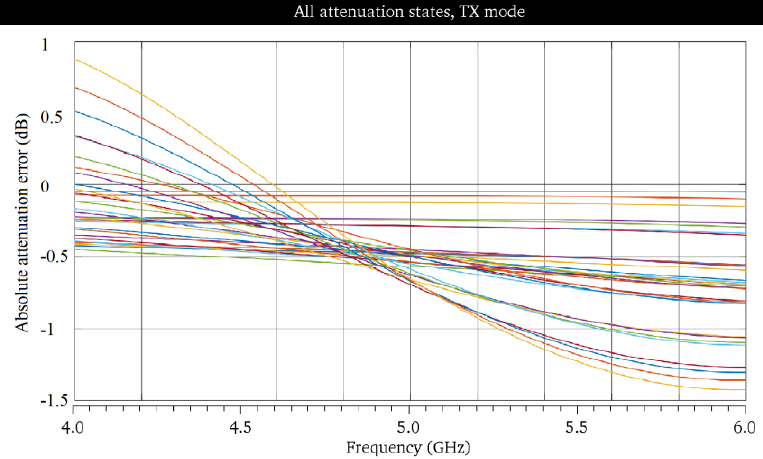
Fig. 8. Frequency dependence of the transfer ratio from the control code in Tx mode.